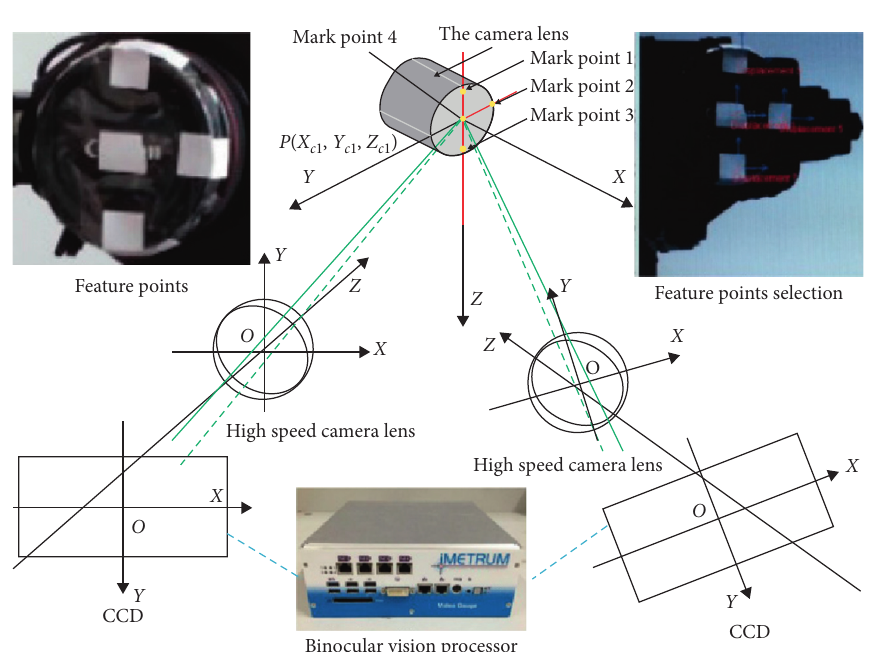
Figure 7: The principle of UAV motion characteristics